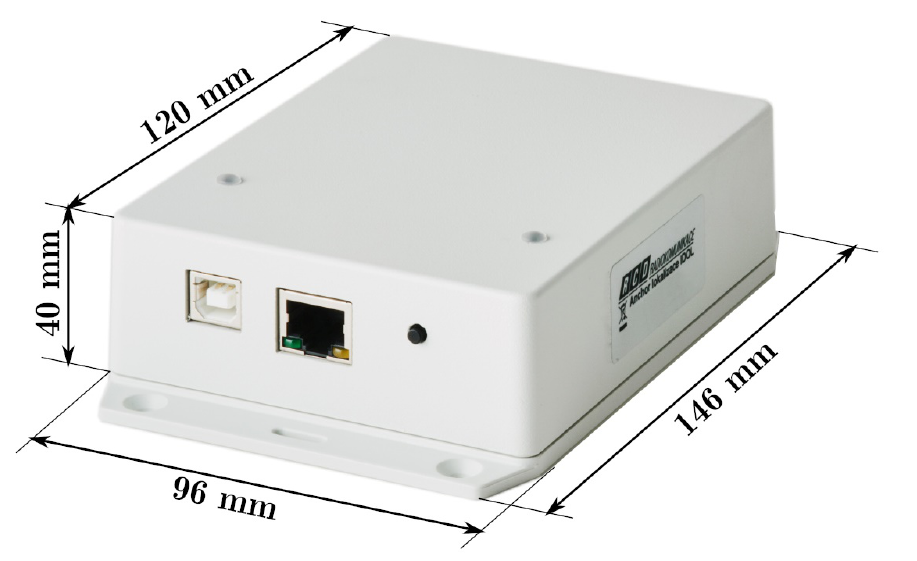
Figure 4. Detailed photo of anchor with dimensions.